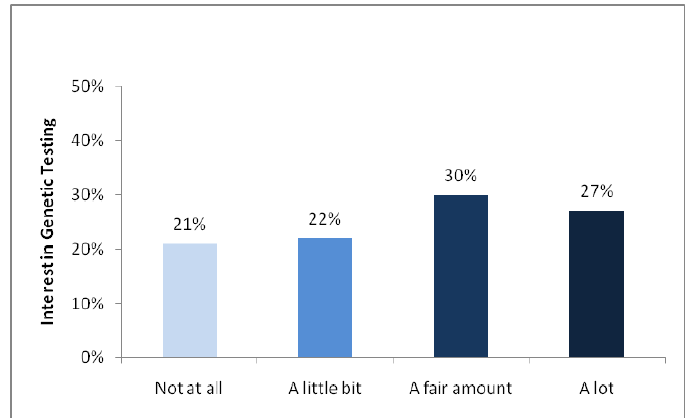
Figure 1. Adolescents’ interest in nicotine addiction susceptibility testing ( n =